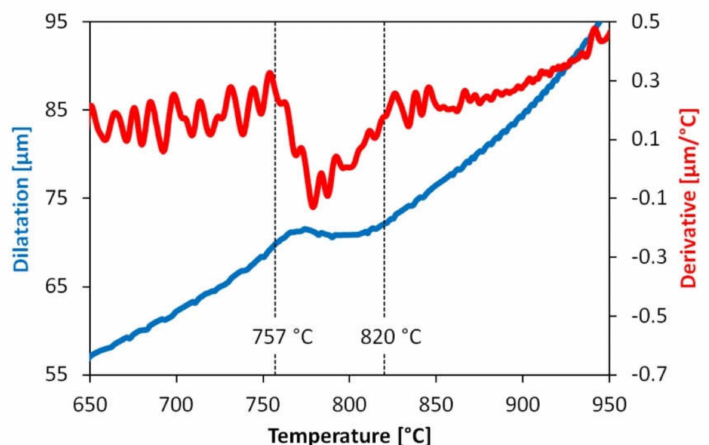
Figure 4. Analysis of the dilatation curve in the area of phase transformations, based on the numerical derivative of the dilatation-temperature data (a heating rate of 0.167 ◦ C · s − 1 ).